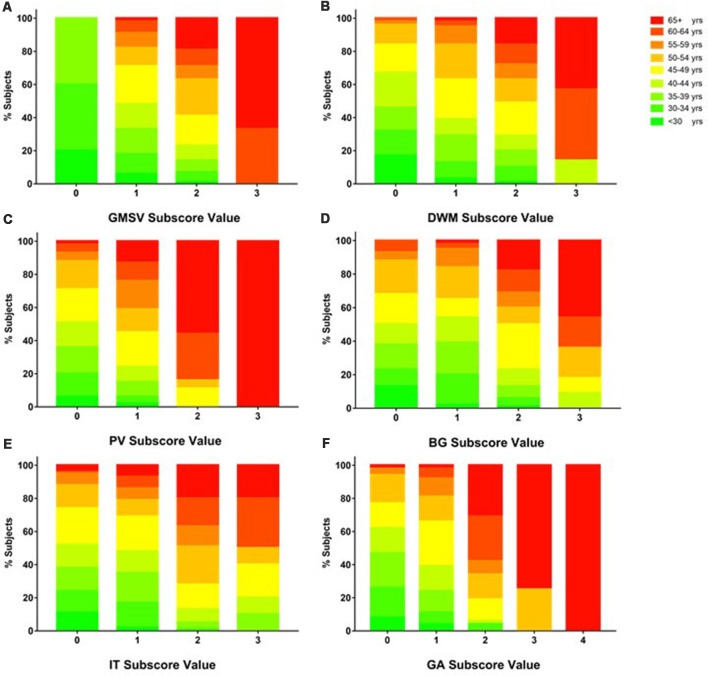
Proportion of subjects in each age group as grouped by BALI subscore values. Data for each subscore are presented using a sub-figure. (A) GM-SV, gray matter and subcortical lesions—subcortical dilated perivascular spaces. (B) DWM, deep white matter lesions. (C) PV, periventricular white matter lesions. (D) BG, lesions in the basal ganglia and surrounding areas. (E) IT, lesions in the infratentorial regions. (F) GA, global atrophy. In each sub-figure, stacked color bars present different age groups. Refer Supplementary Figure S2 for additional data and statistics of the age and BALI subscores relationships.